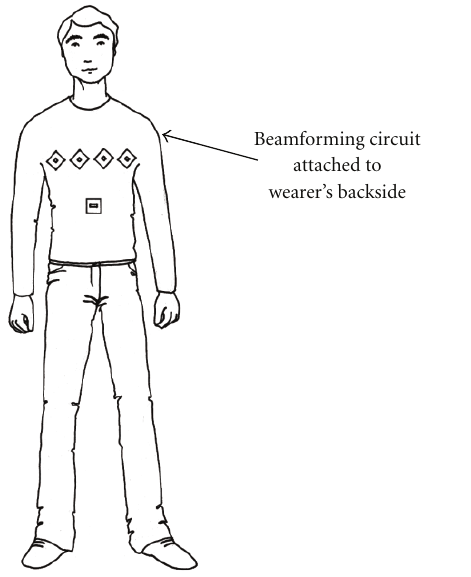
Figure 11: Textile radar system positioned on a human wearer (drawing by Laura Goethals).